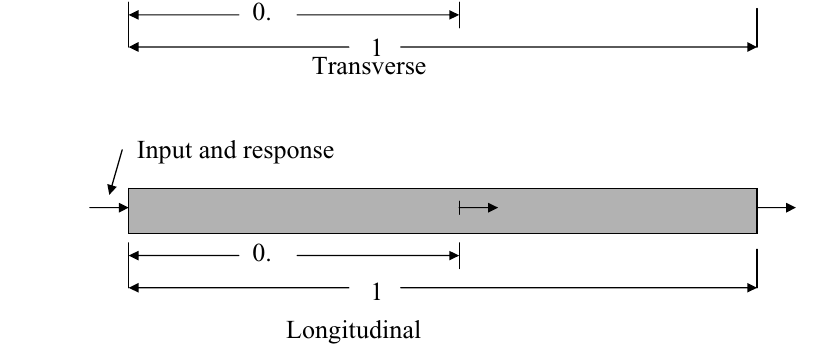
Fig. 3. Sketch of bars used in examples.